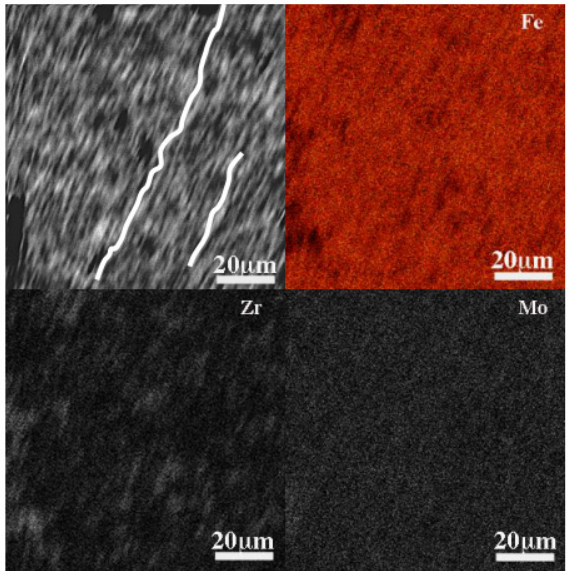
Figure 8. SEM-BEI image and SEM-EDS maps of Fe, Zr and Mo atoms in the 10 mm diameter Fe Ni Mo B Zr ingot quenched in cold 50 16 6 18 10